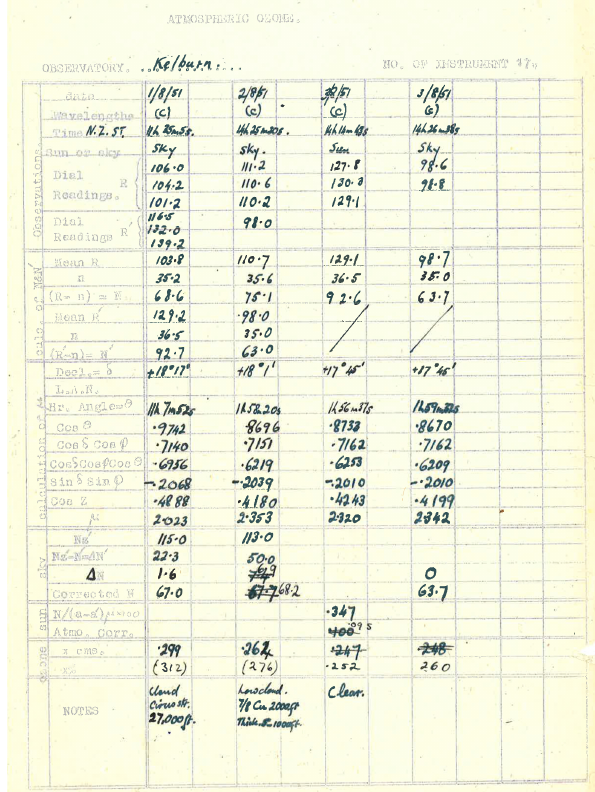
Figure 2. Original data sheet from Wellington, NZ.